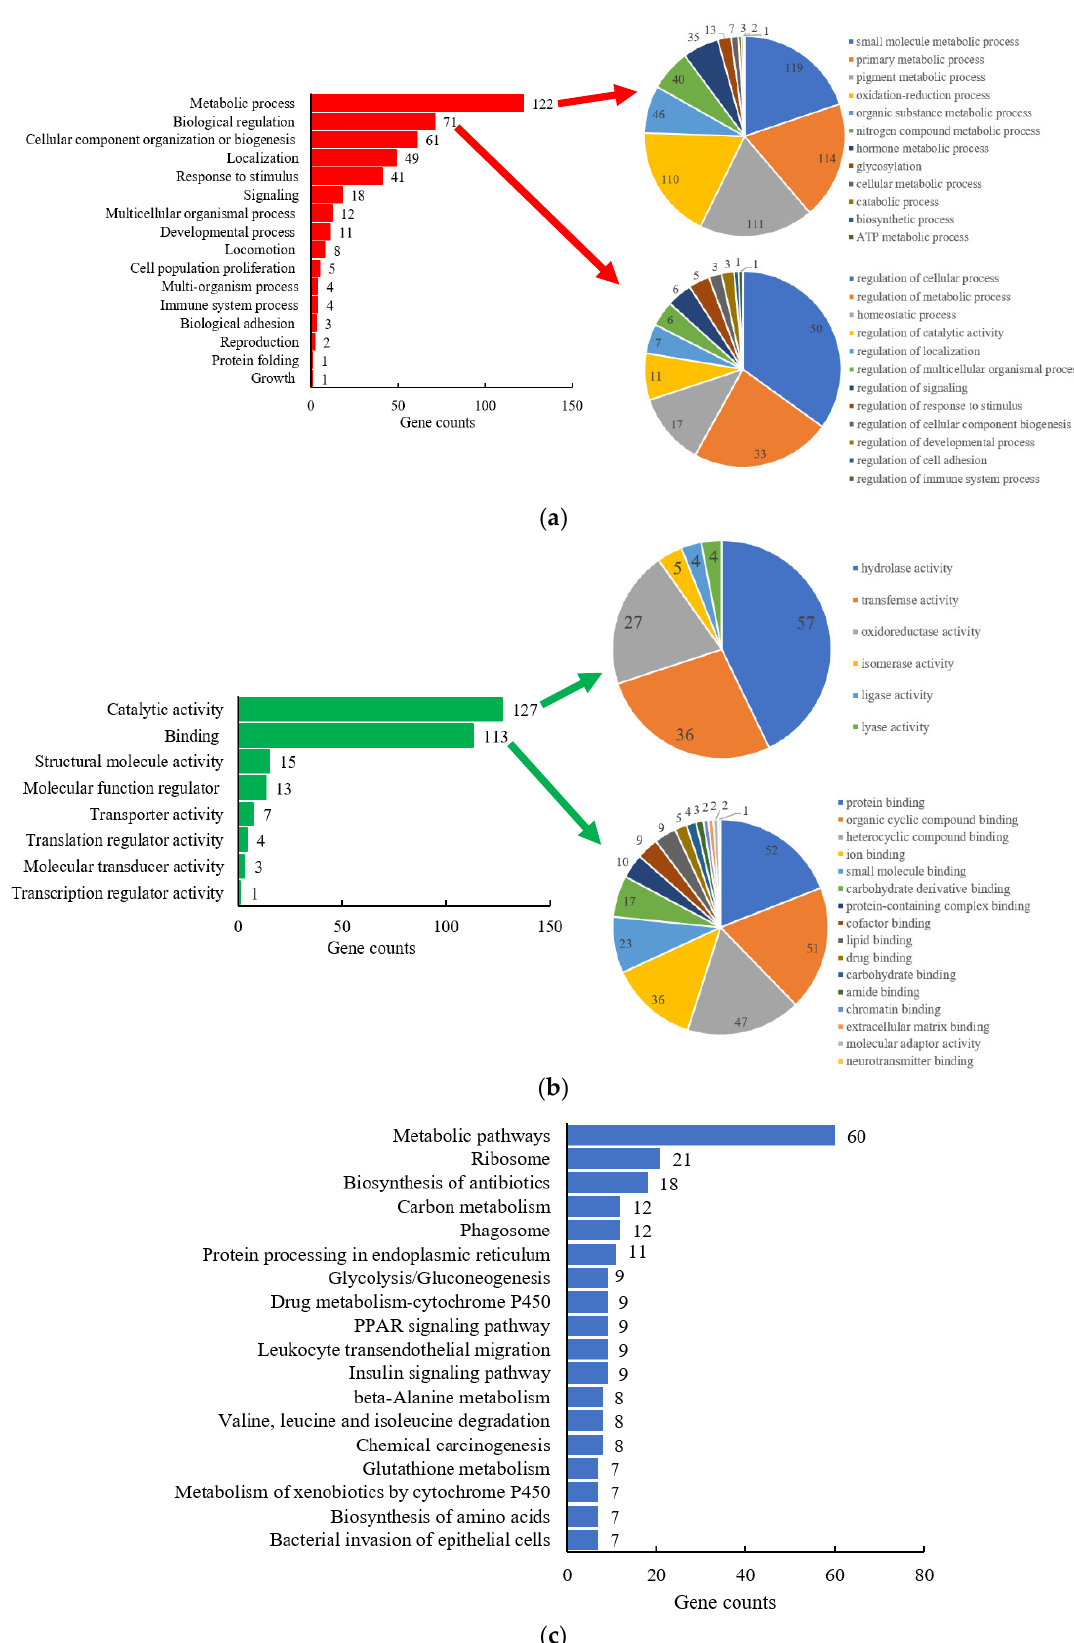
Figure 3. Gene-Ontology (GO) classification and Kyoto Encyclopedia of Genes and Genomes (KEGG) pathway analysis of DEPs. ( a ) Biological process (BP); ( b ) molecule function (MF); ( c ) KEGG pathway. Pie charts in ( a , b ) showed the details of the top two classifications in BP and MF,